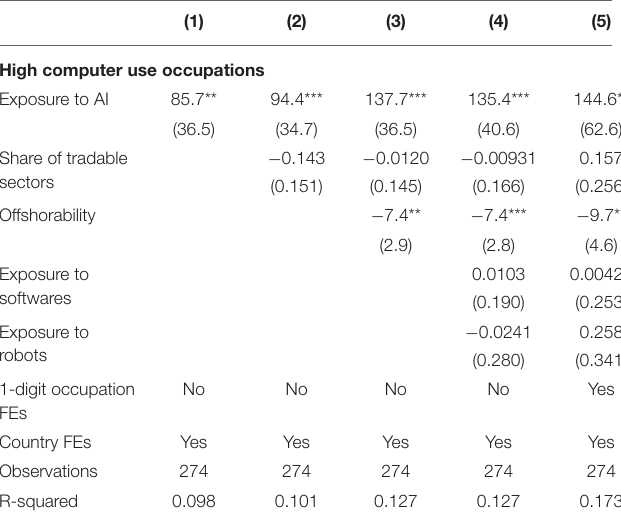
TABLE 3 | The relationship between exposure to AI and employment growth is robust to the inclusion of a number of